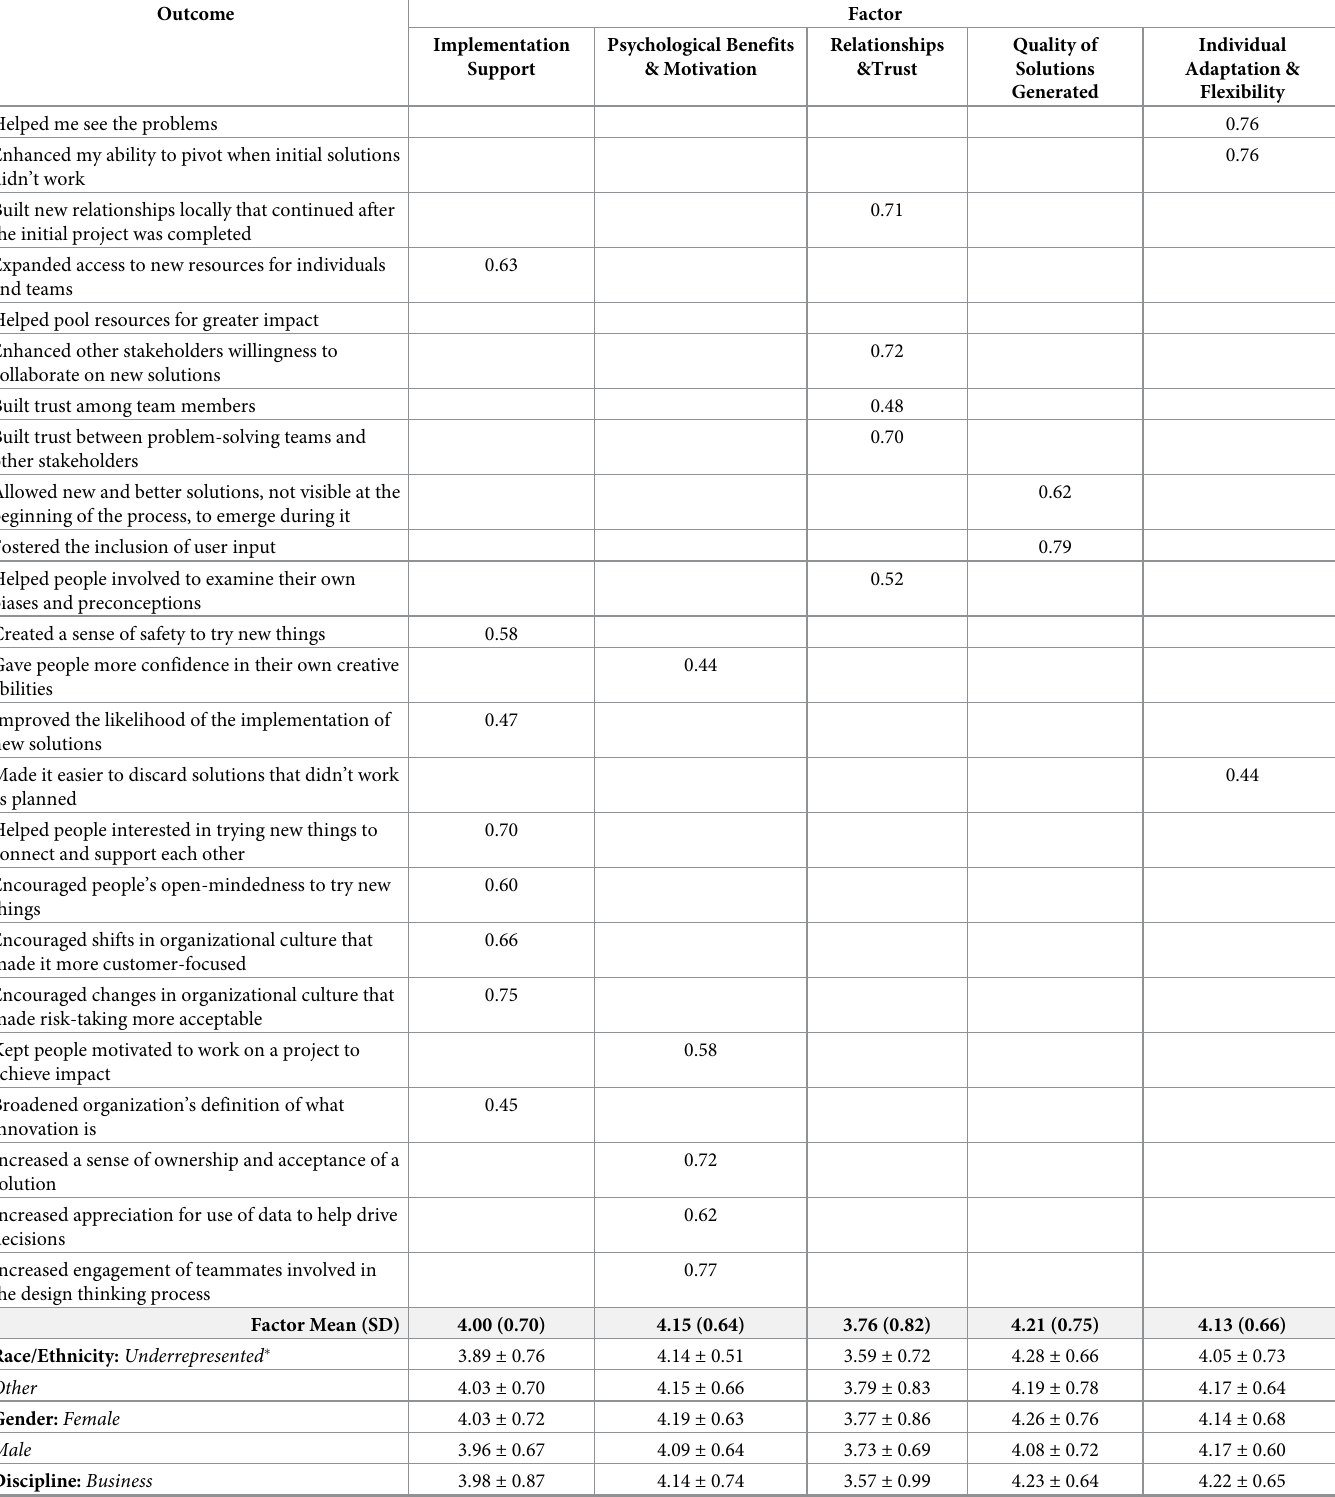
Table 4. Factor loadings and group differences for outcomes of DT in higher education courses (n =